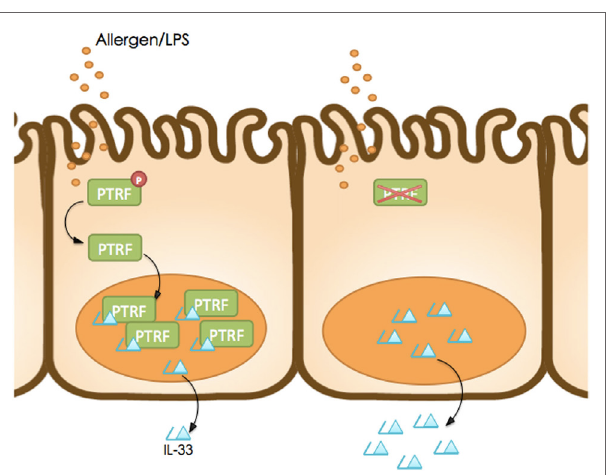
FigUre 8 | Working model. Dephosphorylation of polymerase I and transcript release factor (PTRF) in response to LPS or HDM stimulation leads to nucleus translocation of PTRF and then controls IL-33 release.